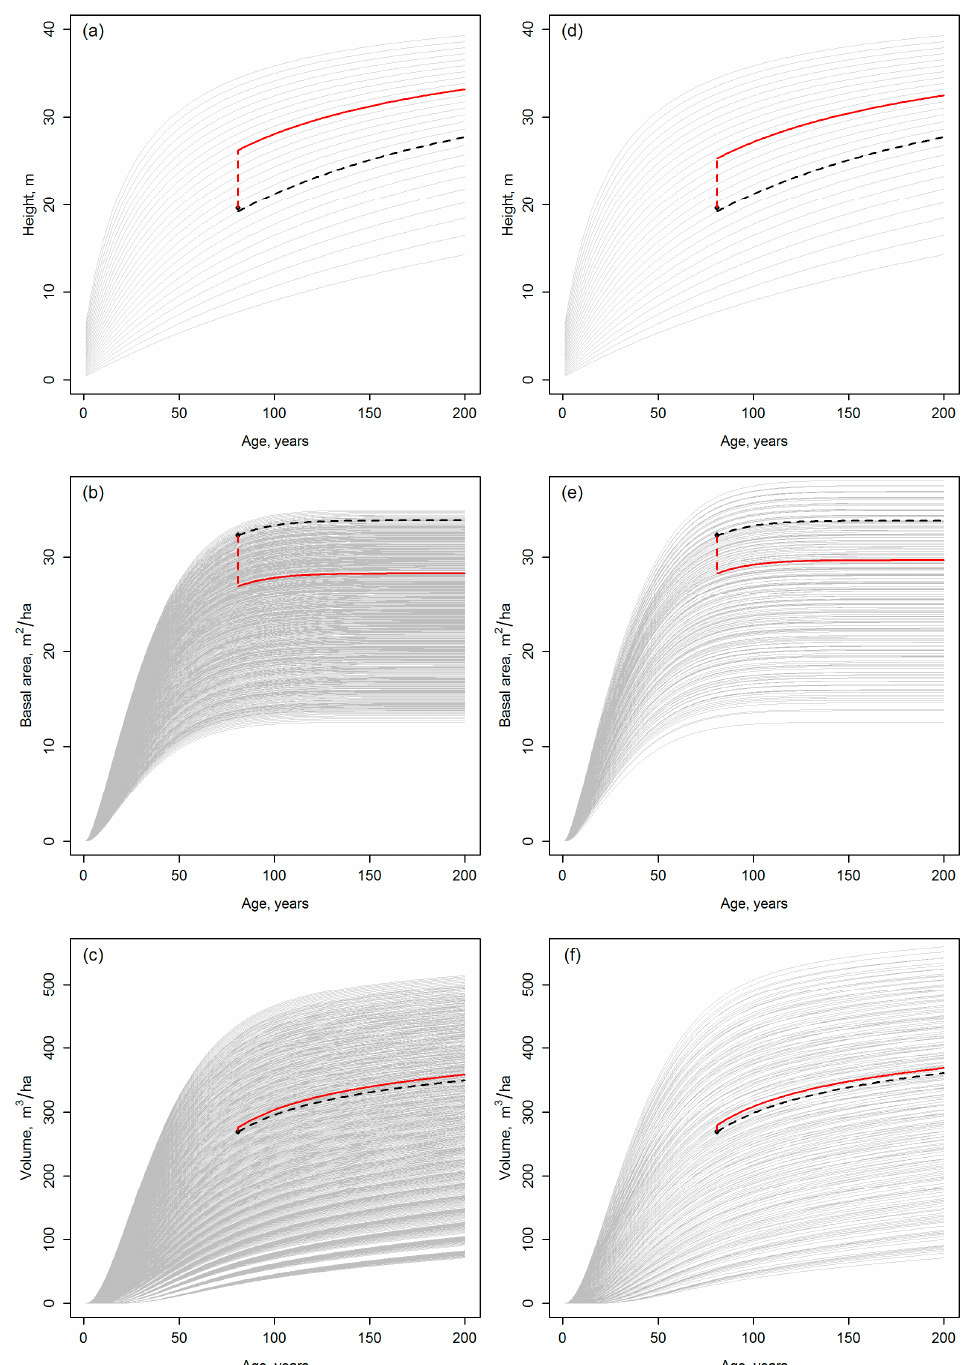
Figure 2. The result of template matching for the top height, basal area, and total volume, respectively; the gray curves show the templates obtained using N ini parameter sequences ( a – c ) from 700 to 2700 stems/ha with an interval of 100 stems/ha; or ( d – f ) from 700 to 6700 stems/ha with an interval of 1000 stems/ha (Section 2.2). The curves matched for these attributes with observations of Table 1 are shown by broken black lines, while the red curves show the final, averaged growth trajectories obtained using the methodology explained in Section 2.3. The broken vertical lines are drawn to highlight the difference between the observations (black dots) and the curves selected for the projections at the age of the